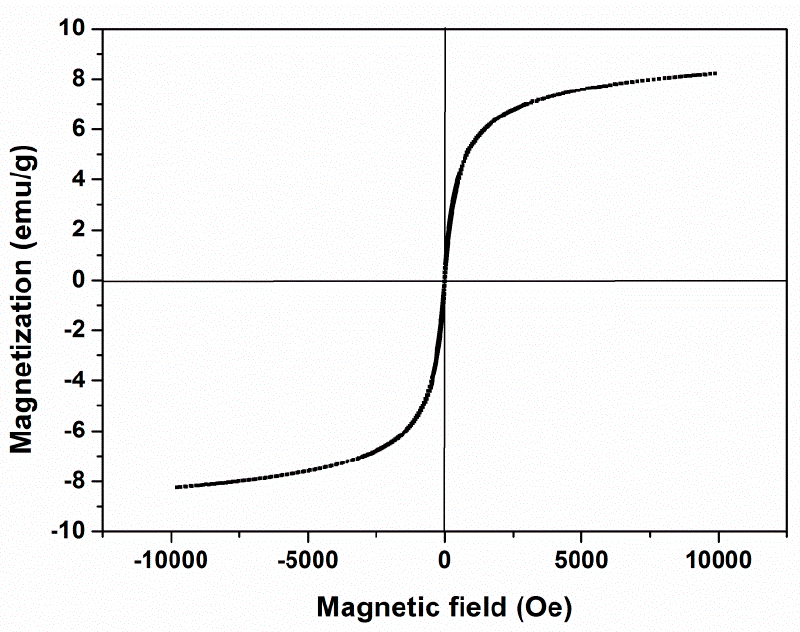
Figure 4. Magnetization curves of magnetic PGMA-g-PPy microspheres.